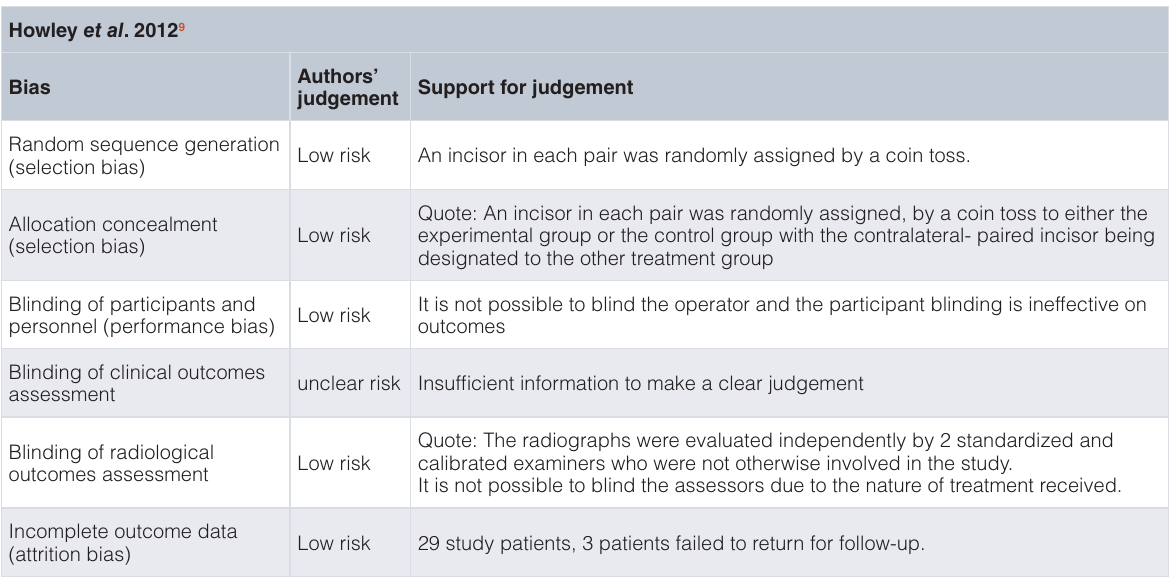
Table 5. Risk of bias in Howley et al . 2012.